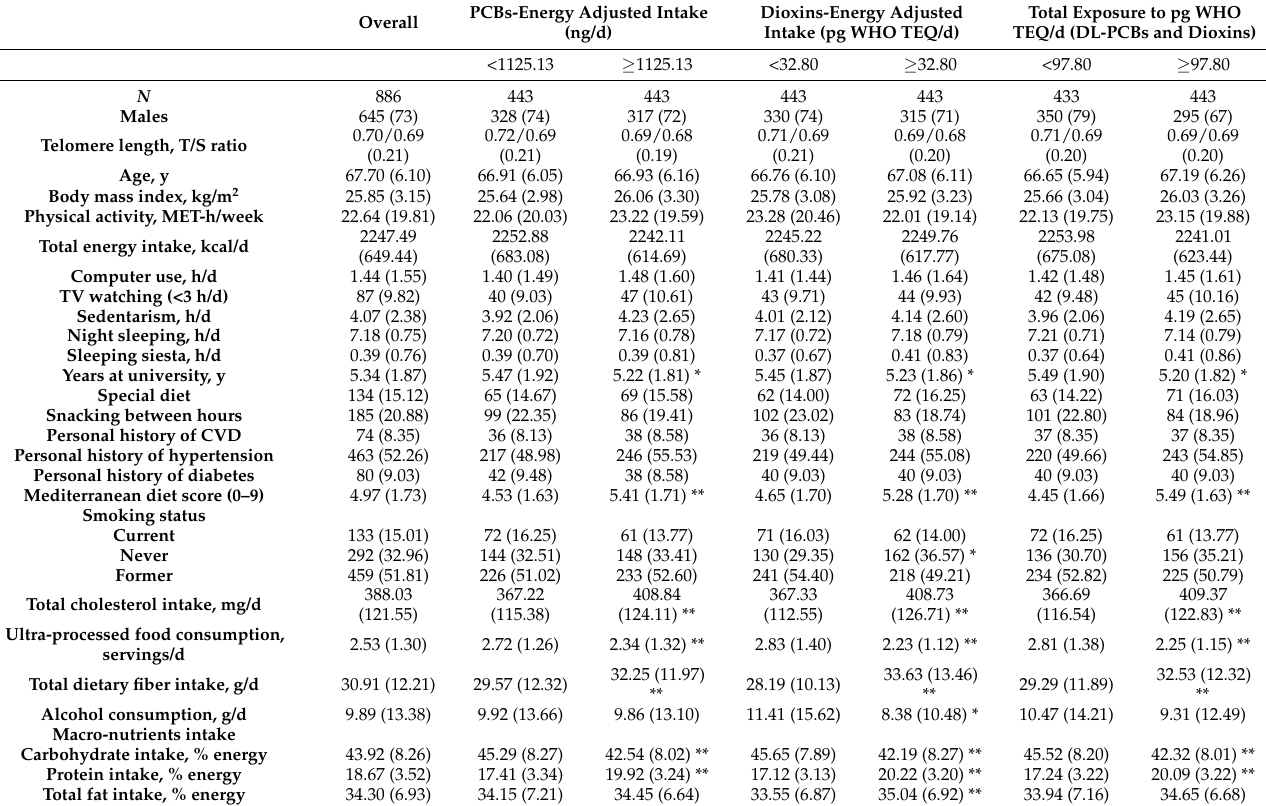
Table 1. Descriptive characteristics of the study participants from the SUN project according to the median of dietary exposure to PCBs and dioxins energy-adjusted intake of participants over 55 years from the SUN project ( n =